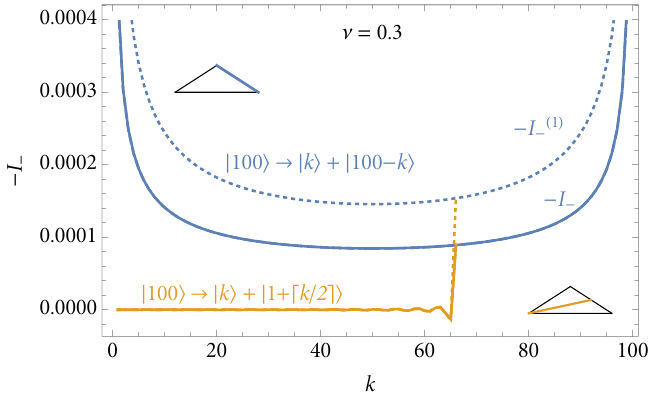
Figure 16 . Comparison of a numerical computation of the integral I − (solid curves) with the two analytic approximations I (0) , (4.6) (dashed curves) and I (1) , (4.8) (dotted curves). The dashed − − curves always fall so close to the solid curve that they are indistinguishable. The simpler analytic formulation, I (1) , works very well away from threshold but deviates close to the threshold, leading − to the visible dotted curves. As in figure 15, the inset triangles illustrate the slice through the branching ratio triangle that is plotted. We show the case ν = 0 . 3 because it shows a larger discrepancy, and thus a more visible dotted curve, than the case ν = 0 . 75